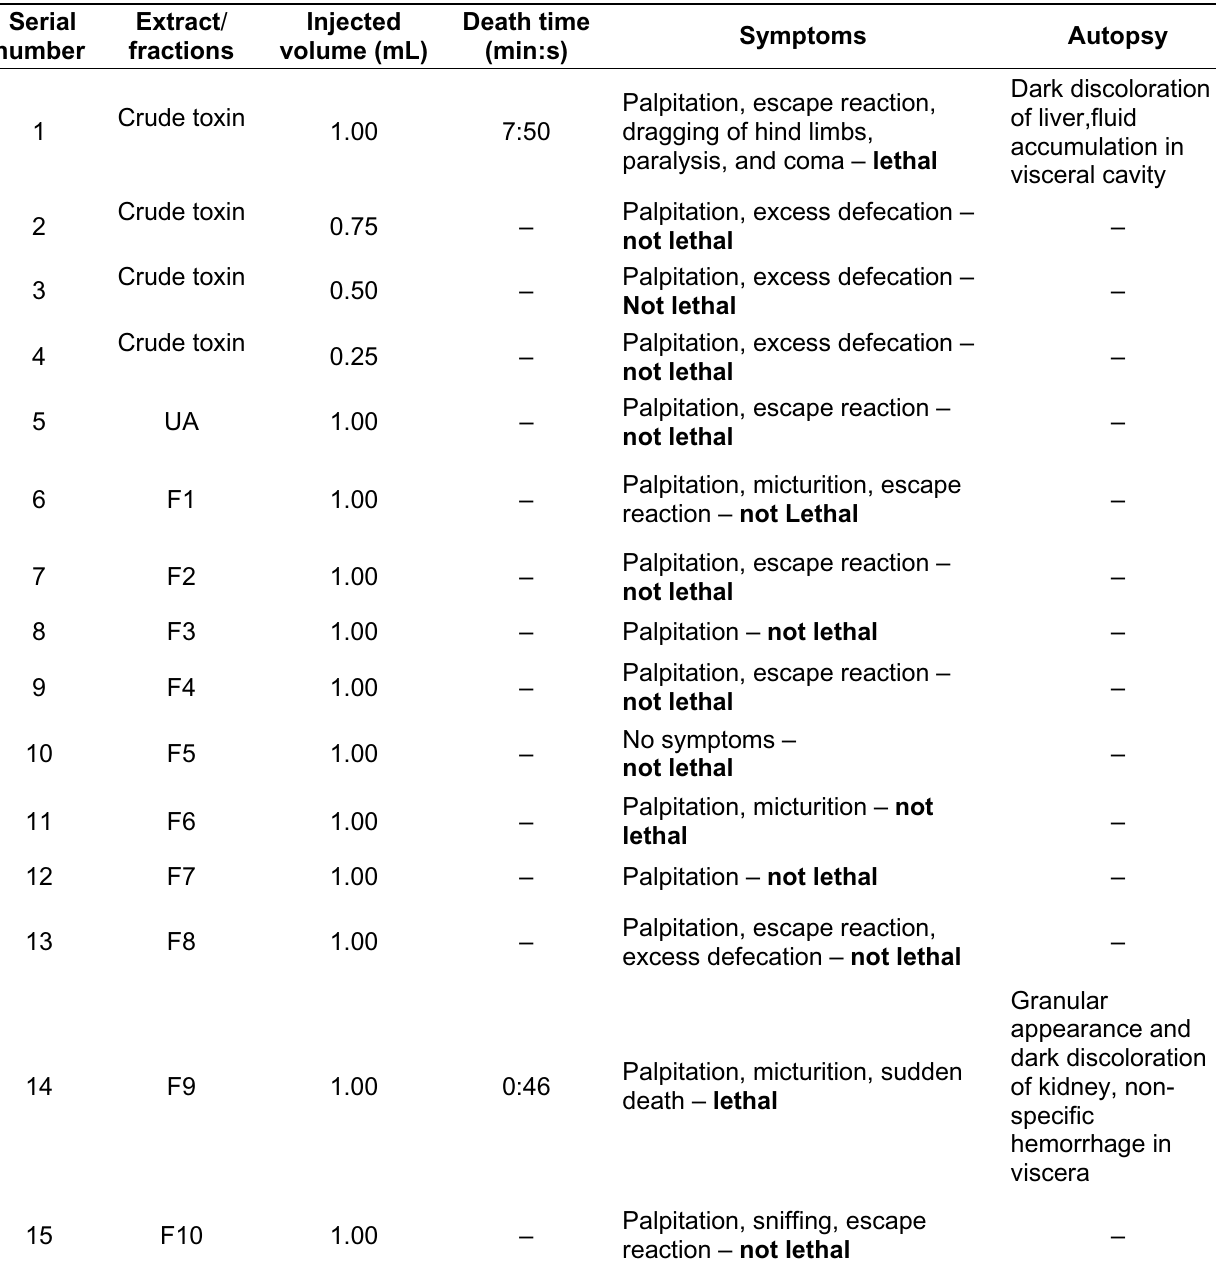
Table 2. Toxicity of starfish crude toxin and its fractions (at 5.0 mg/mL) IP in male albino mice (20 ± 2